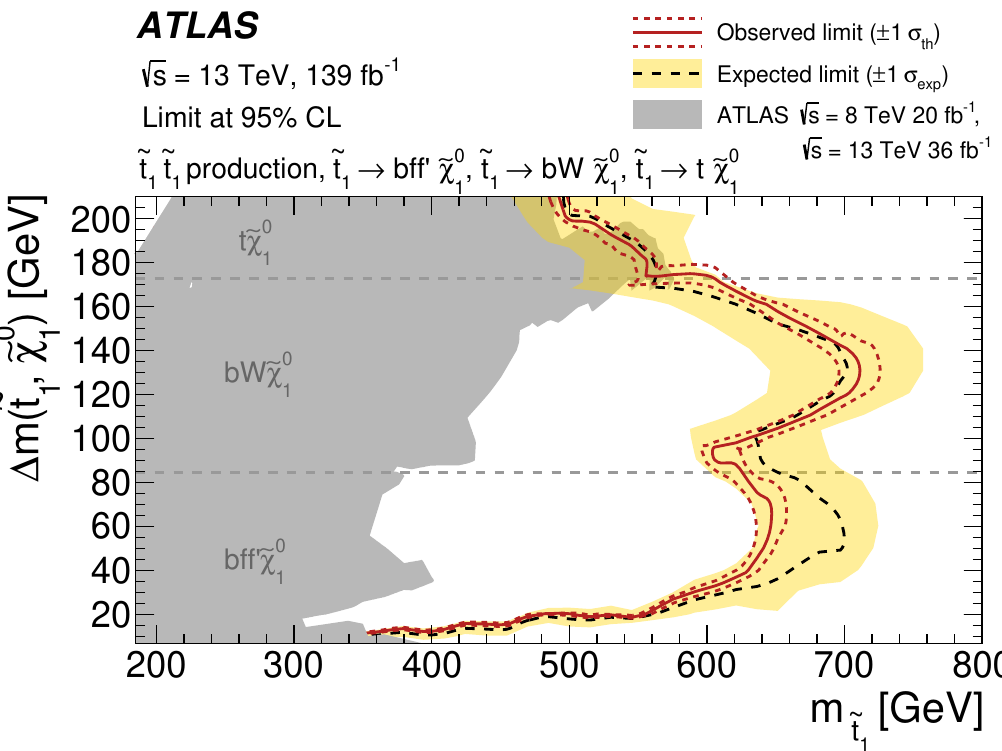
Figure 14. Expected and observed 95% CL excluded regions in the plane of ∆( m ˜ for direct stop pair production assuming either a ˜ t 1 → t + ˜ χ 0 1 , ˜ t 1 → bW ˜ χ 0 1 or ˜ t 1 → bff 0 ˜ χ 0 1 decay with a branching ratio of 100%. The excluded regions from previous publications [29–31, 137] are shown by the shaded area and include additional topologies. The horizontal dashed lines indicate the kinematical border of the stop decay modes.